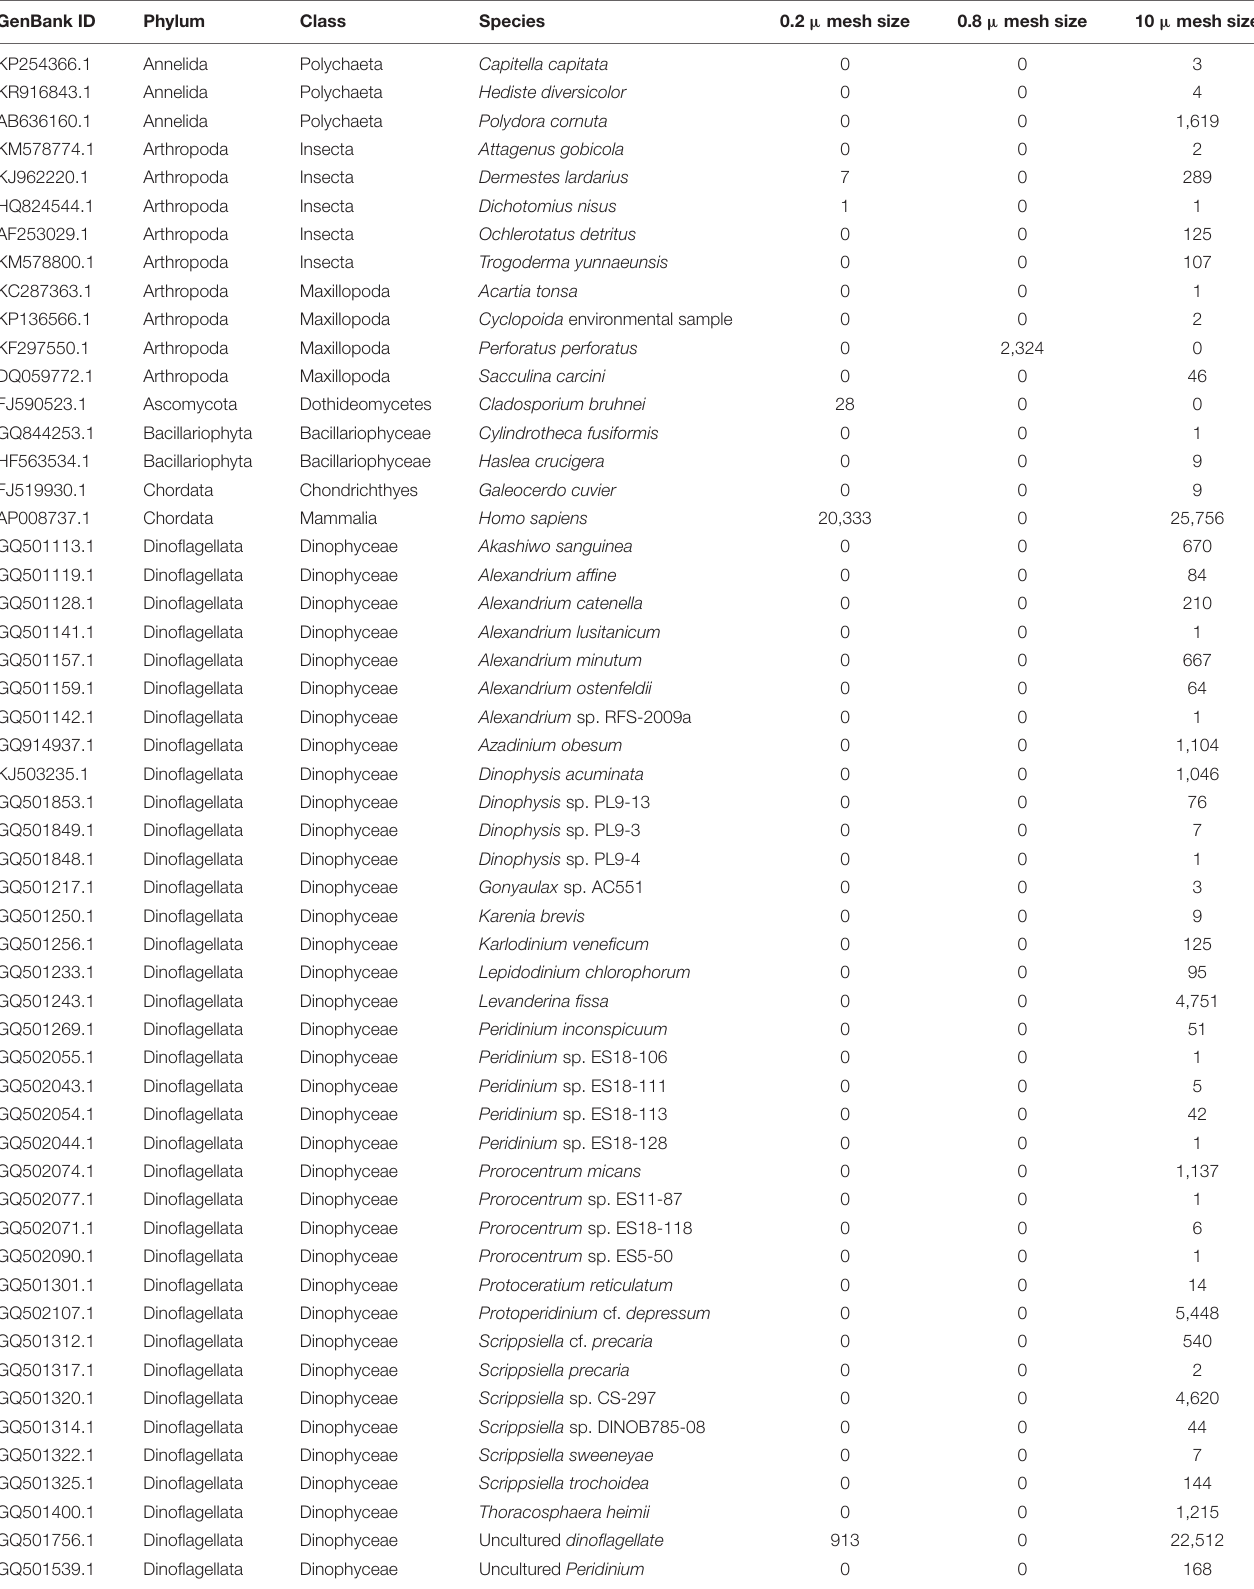
TABLE 1 | Sequences matched a correct reference sequence from the GenBank database per filter, after merging and quality